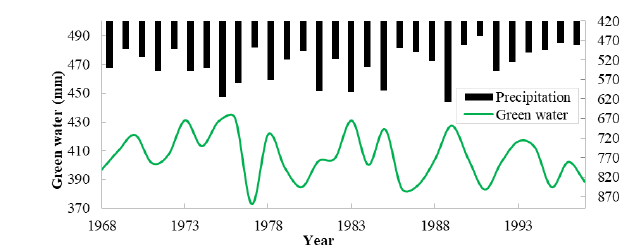
Figure 6. The inter-annual variability of the precipitation and green water.